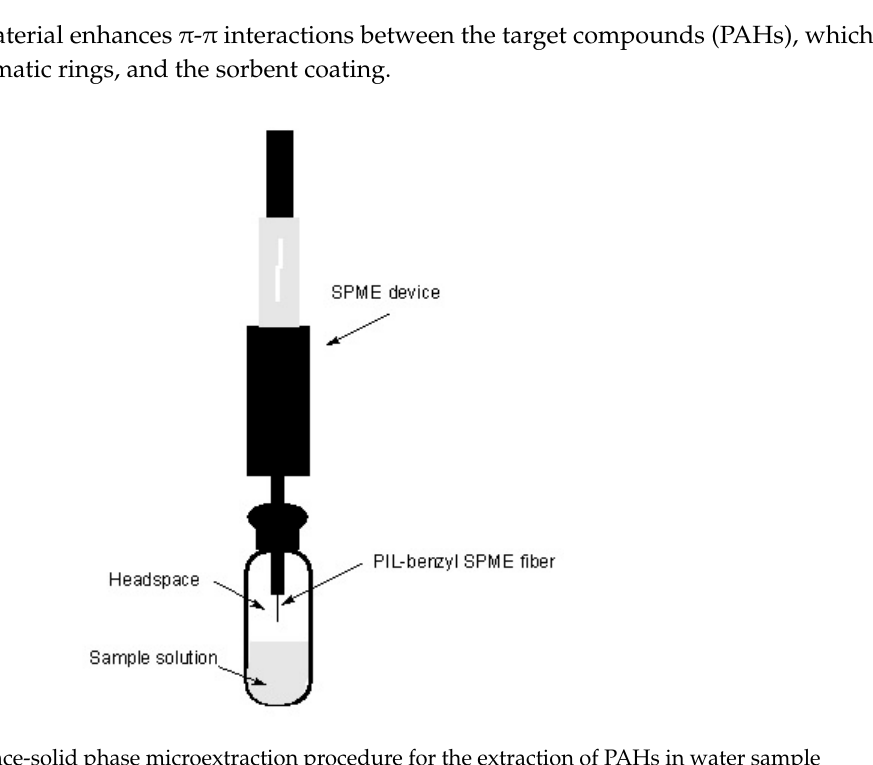
Figure 3. Headspace-solid phase microextraction procedure for the extraction of PAHs in water sample using a polymeric ionic liquid-based fiber.